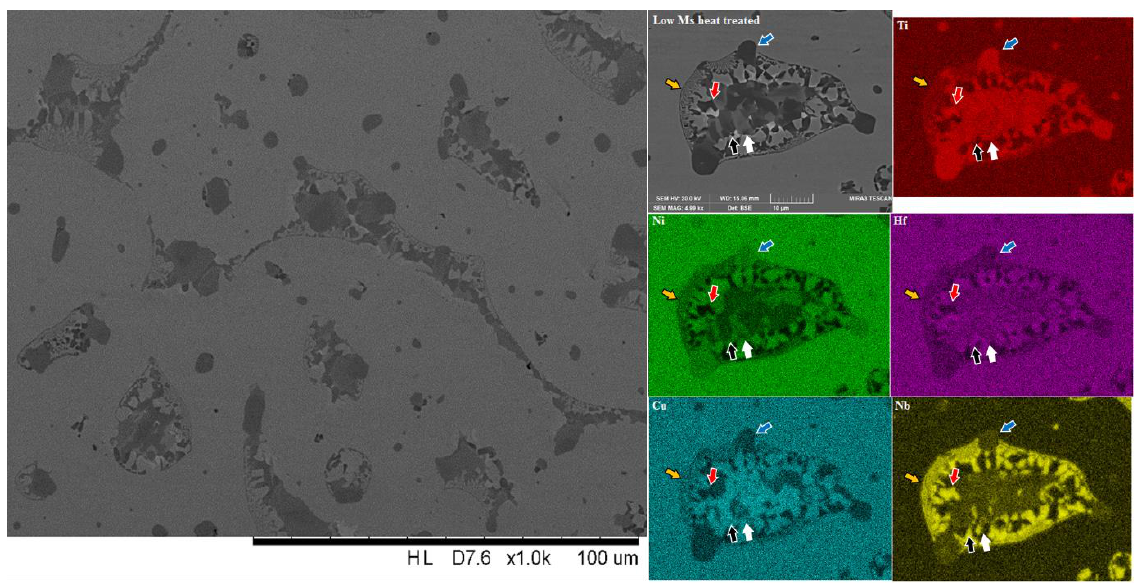
Figure 13. Backscatter image and EDS mapping of precipitates of heat treated Ti-Ni-Hf-Cu-Nb low M s sample shows the change of microstructure. Solids 2022 , 1 , FOR PEER REVIEW